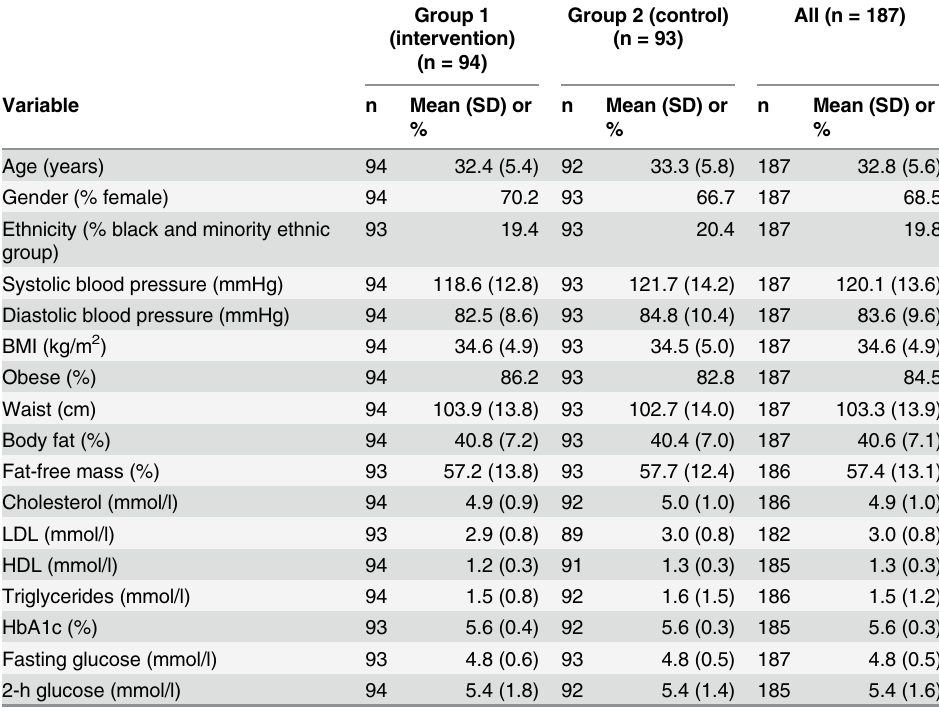
Table 1. Descriptive characteristics at baseline by randomisation